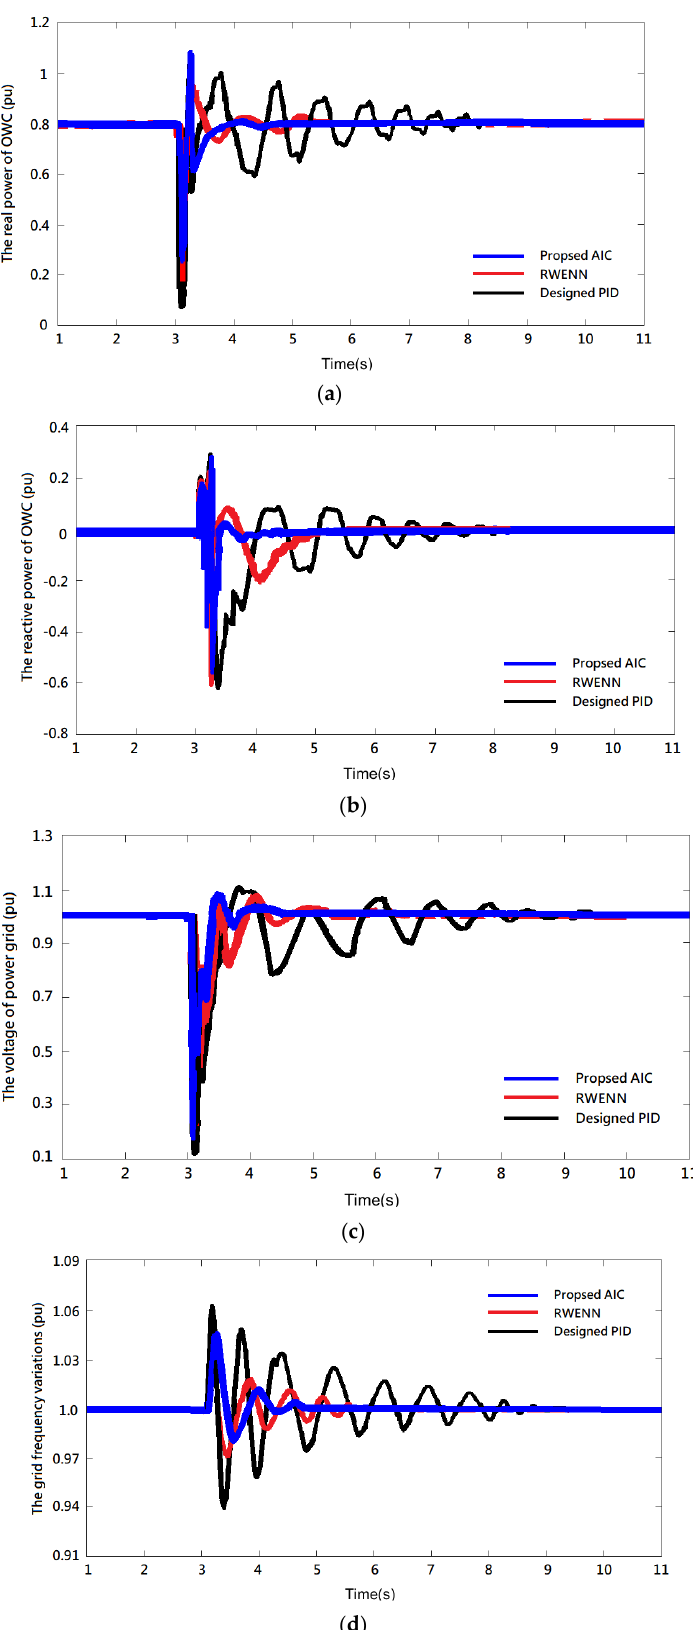
Figure 5. Dynamic responses of the studied system with load disturbance: ( a ) turbine speed, ( b ) AC line voltage, ( c ) DC link voltage, and ( d ) grid side real power.